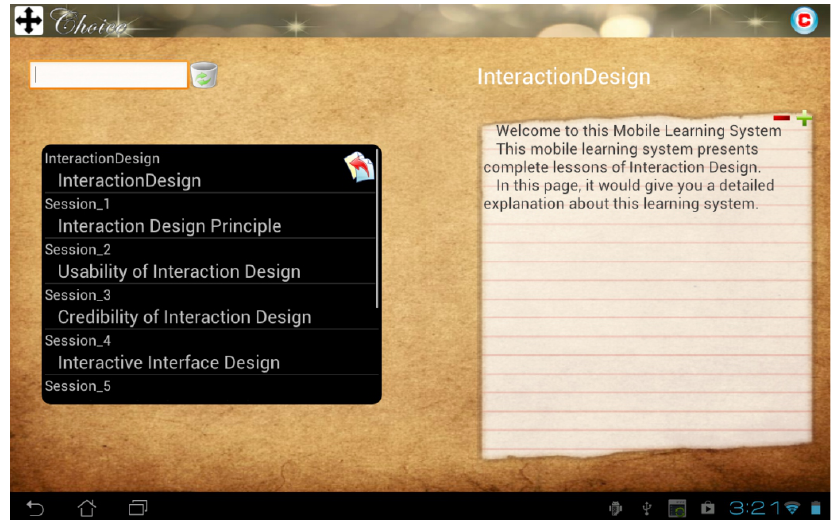
Figure 8. Serialist Version of